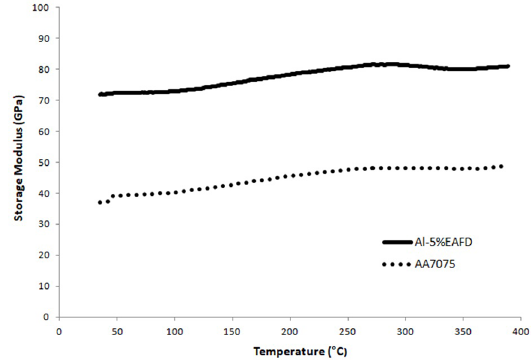
Figure 5. Storage modulus vs. temperature from DMA at frequency of 1 Hz, for Al-5%EAFD and AA7075 alloy.